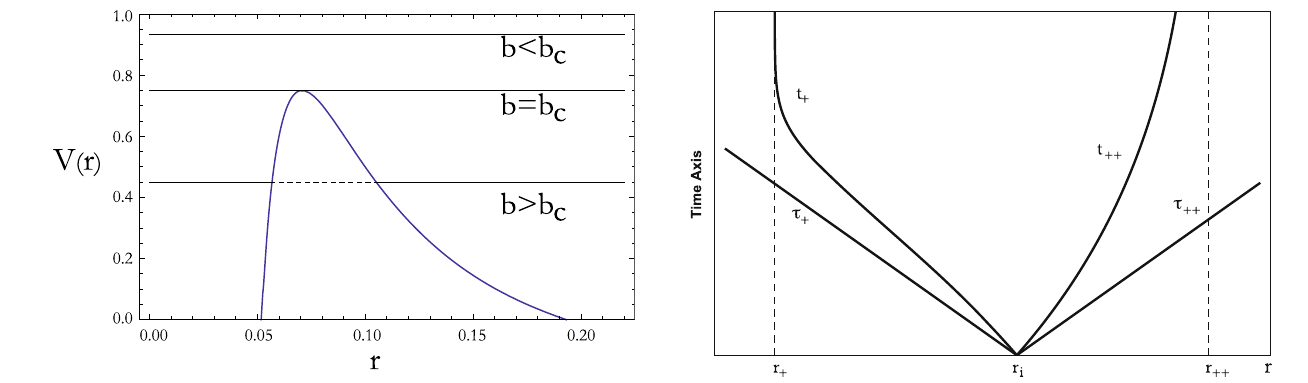
Fig. 1 Plot of the effective potential V ( r ) versus the radial coordinate r , for fixed parameter L = 10 − 1 , λ = 2 × 10 − 1 and Q = 10 − 1 (in arbitrary units)